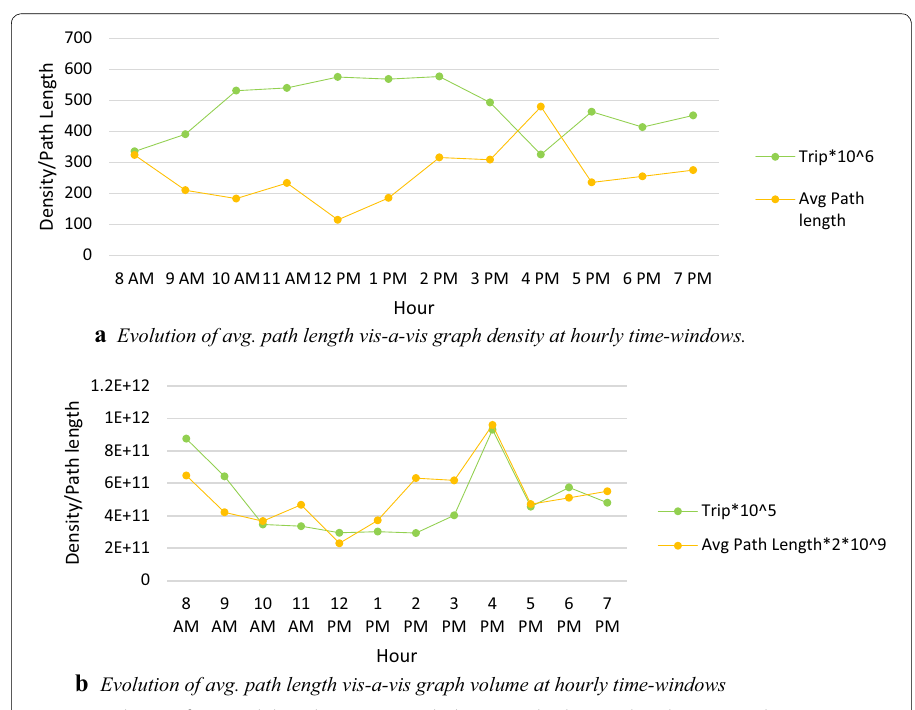
Fig. 11 Evolution of avg. path length vis-a-vis graph density and volume at hourly